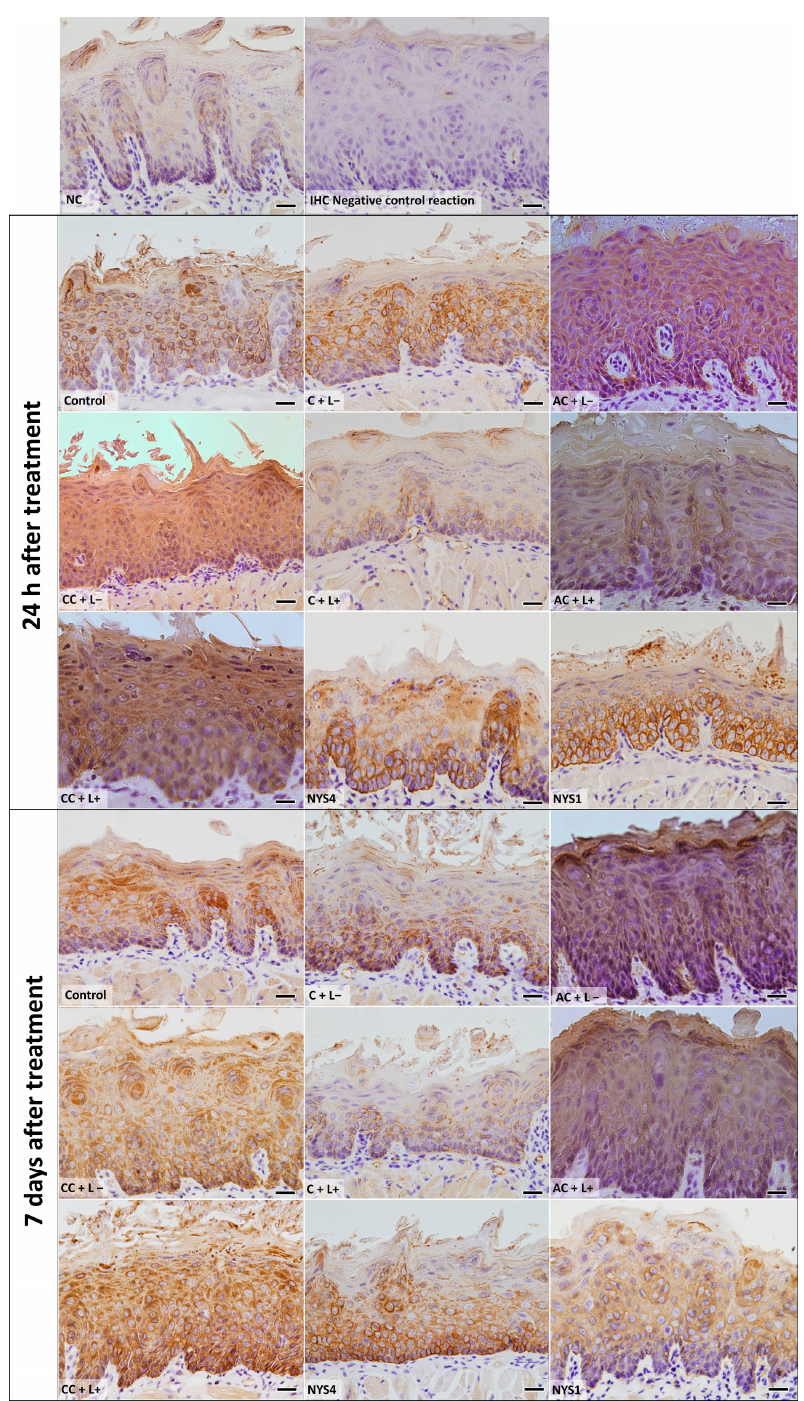
Figure 10. Light micrographs showing portions of sections of the tongue dorsal mucosa submitted to IHC for CK14 detection and counterstained with haematoxylin. NC group: healthy and untreated animals; Control group: infected animals that did not receive any treatment (C − L − ); C + L+, AC + L+, and CC + L+ groups: animals treated with aPDT mediated by free CUR, anionic and cationic